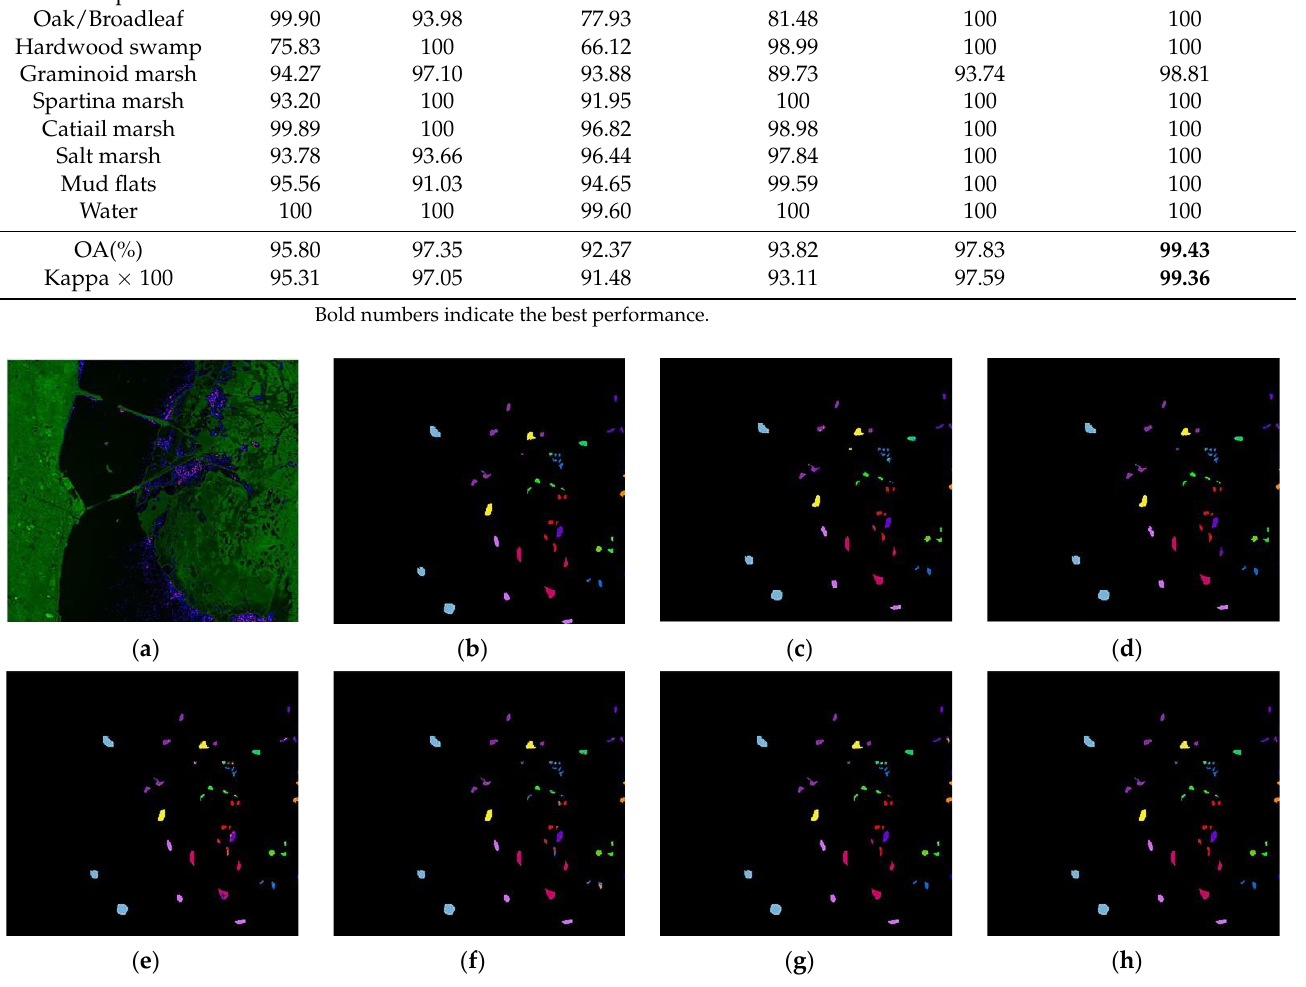
Figure 10. Kennedy Space Center dataset Classification: ( a ) False color image, ( b ) Ground-truth map, ( c ) EPF, ( d ) IFRF, ( e ) RPNET, ( f ) CNN-AL, ( g ) SS-RMG, ( h ) Improved-ADL.